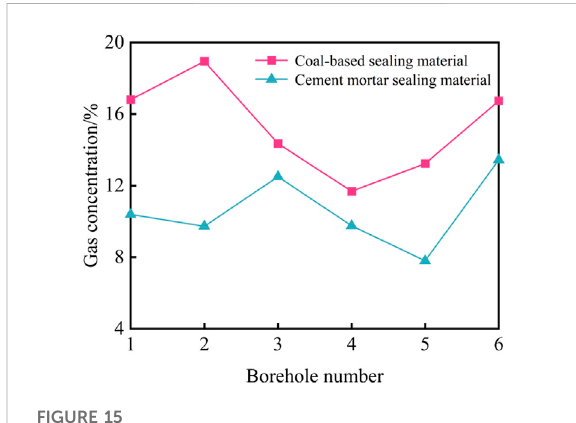
FIGURE 15 Comparison of sealing effect of two